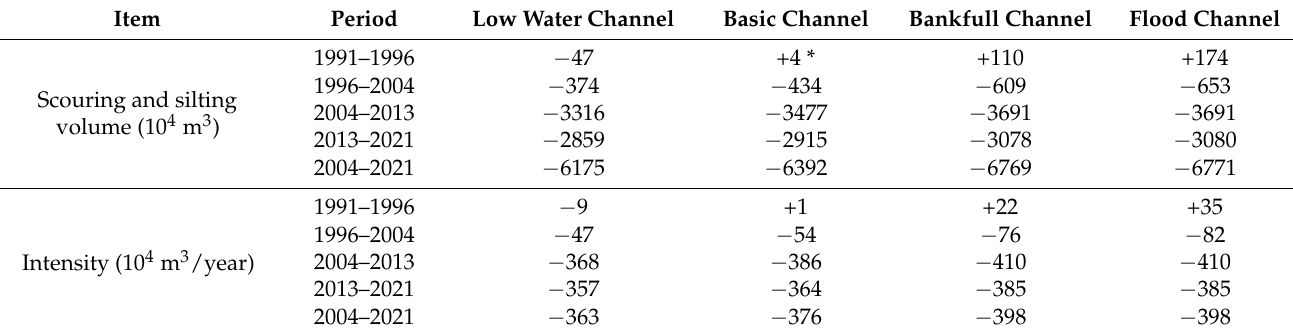
Figure 8. Cumulative amount of channel erosion and deposition. Table 2. Scouring and silting volume and intensity in different periods.